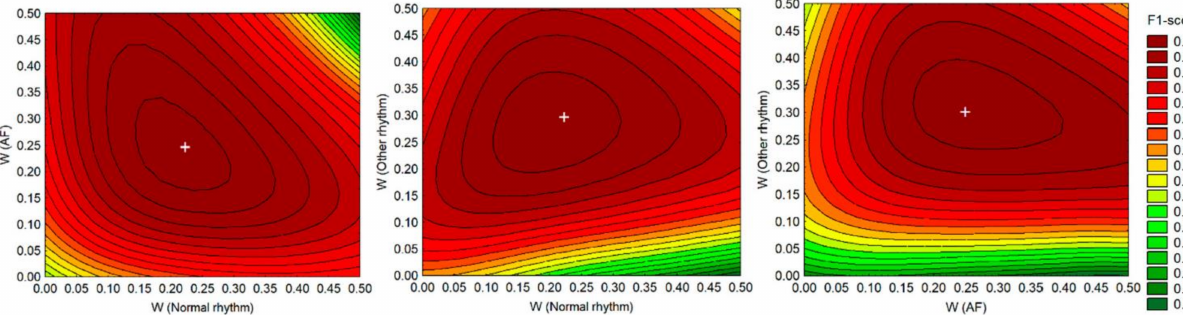
Figure 5. Influence of rhythm class weights W (Normal, AF and Other rhythms) on DenseNet-3@128-32-4 performance. The contour plots of F1-score measured within W grid [0; 0.5] justify the choice of the weights as the average values in the mid-area of maximal performance (+mark): W(Normal) = 0.23, W(AF) = 0.25, W(Other) = 0.3.